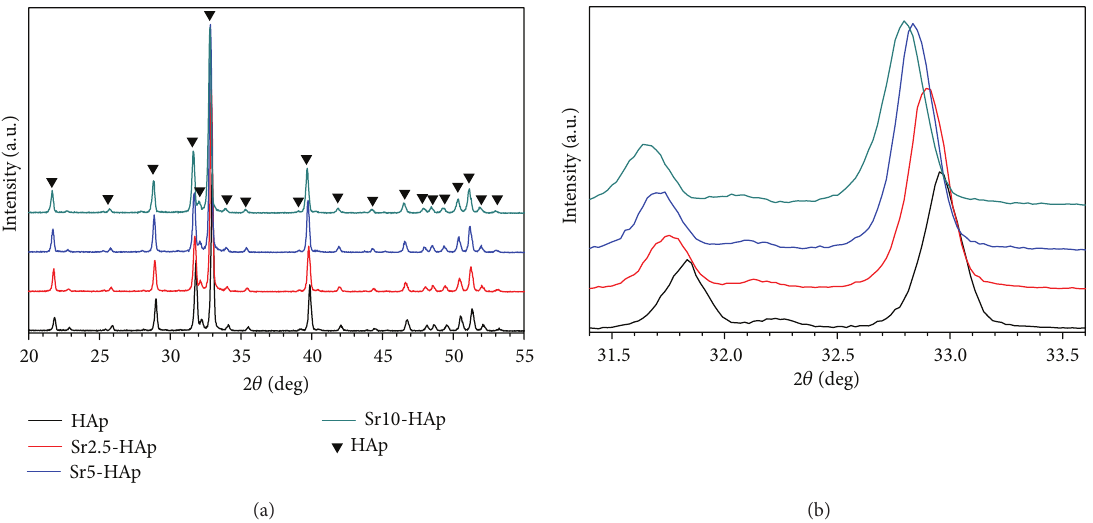
Figure 2: XRD patterns of the obtained HAp and Sr-substituted HAp whiskers.